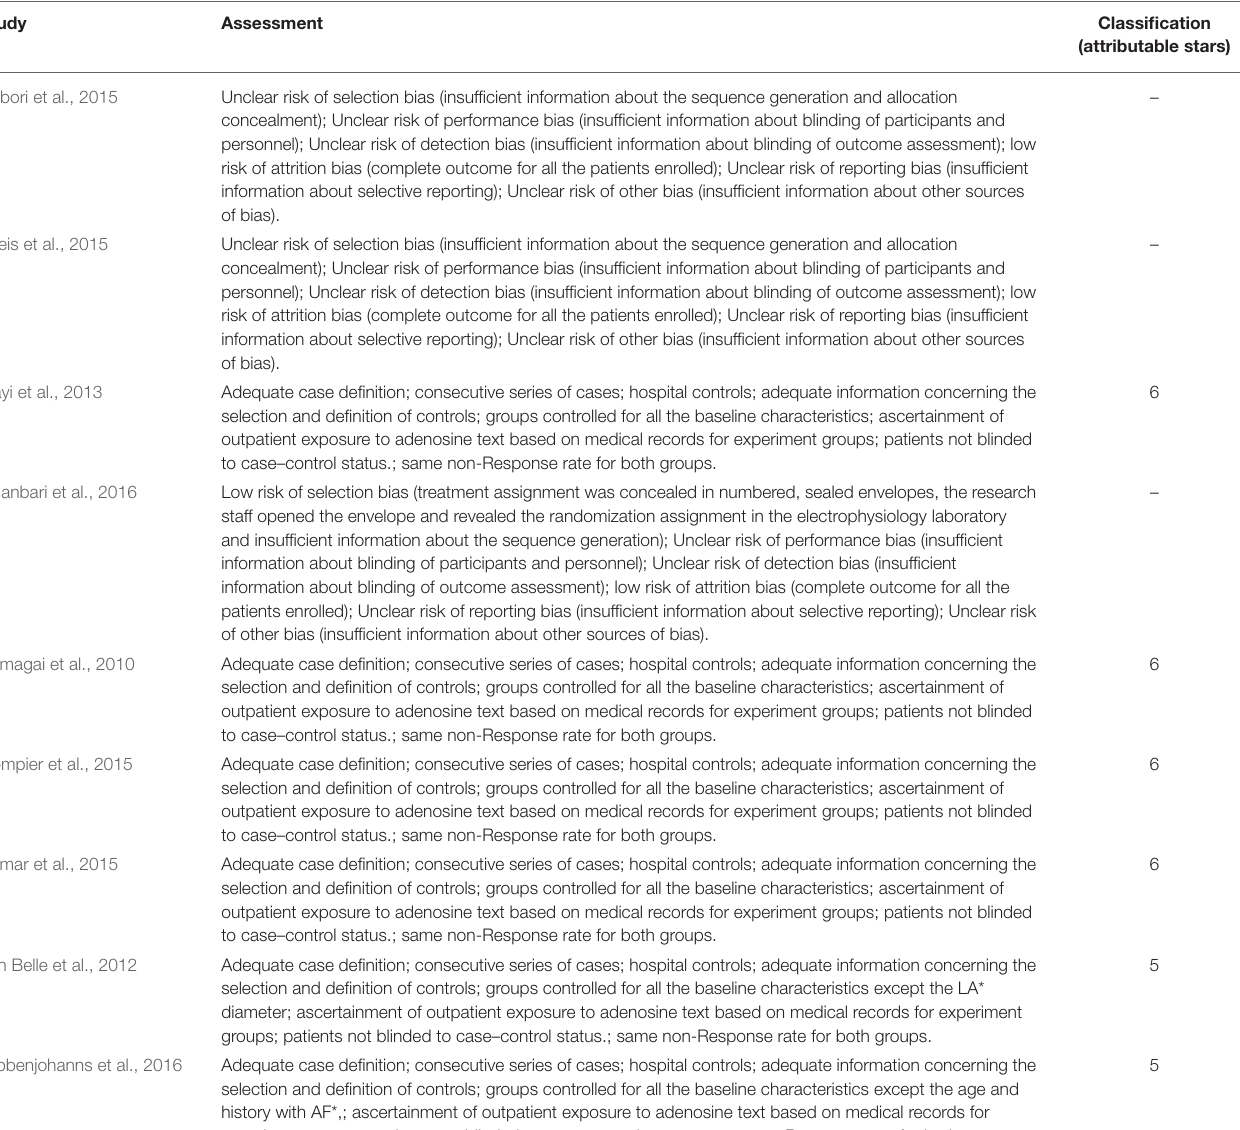
TABLE 3A | Assessment of the quality of included studies in Group A ( + ) and Group A ( −